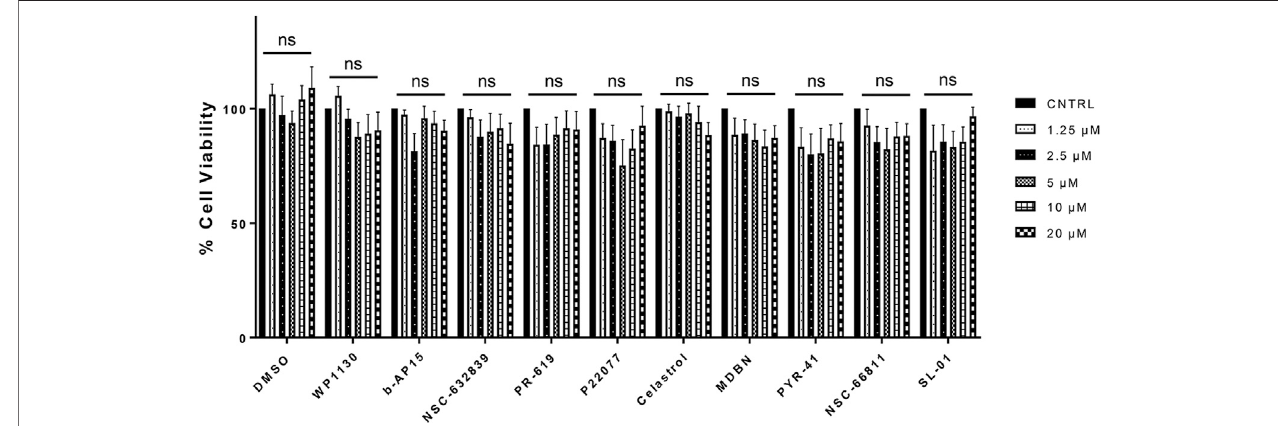
FIGURE4| TheEffectsofSelectedCompoundsontheCellViability.MTTassaywasperformedusingHEK293cellstreatedwithselectedcompoundsat1.25,2.5, 5, 10, and 20 µM concentrations. Data are presented as means ± SEM calculated from four independent experiments and compared by Student ’ s t -test, using GraphPad Prism. “ ns ” stands for not signi fi cant.